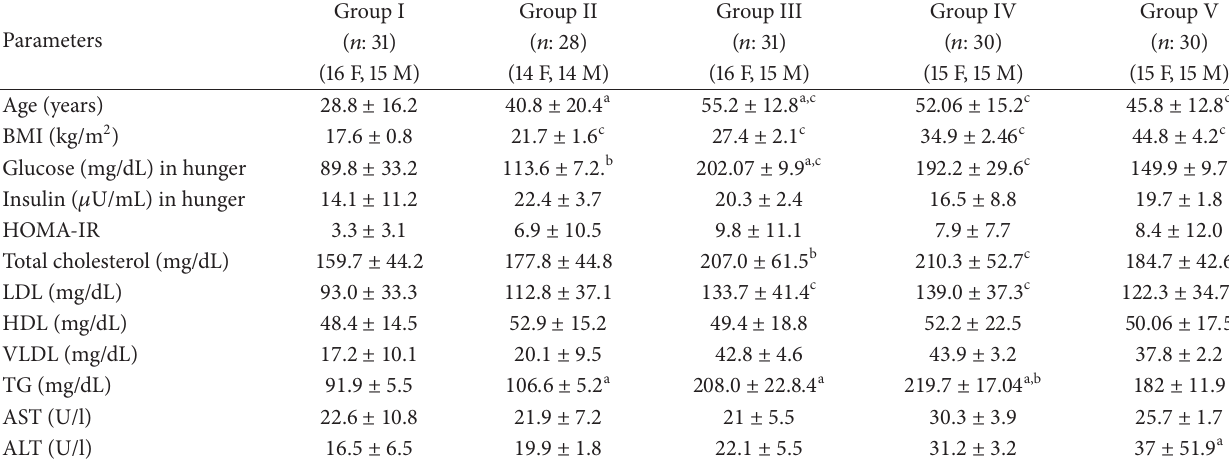
Table 1: Demographic characteristics and routine biochemical parameters of study groups.